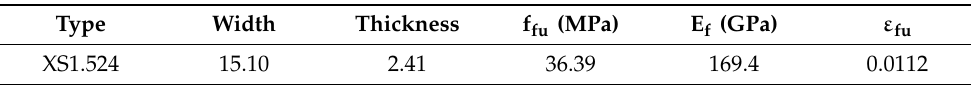
Table 4. Mechanical characteristics of CFRP strips